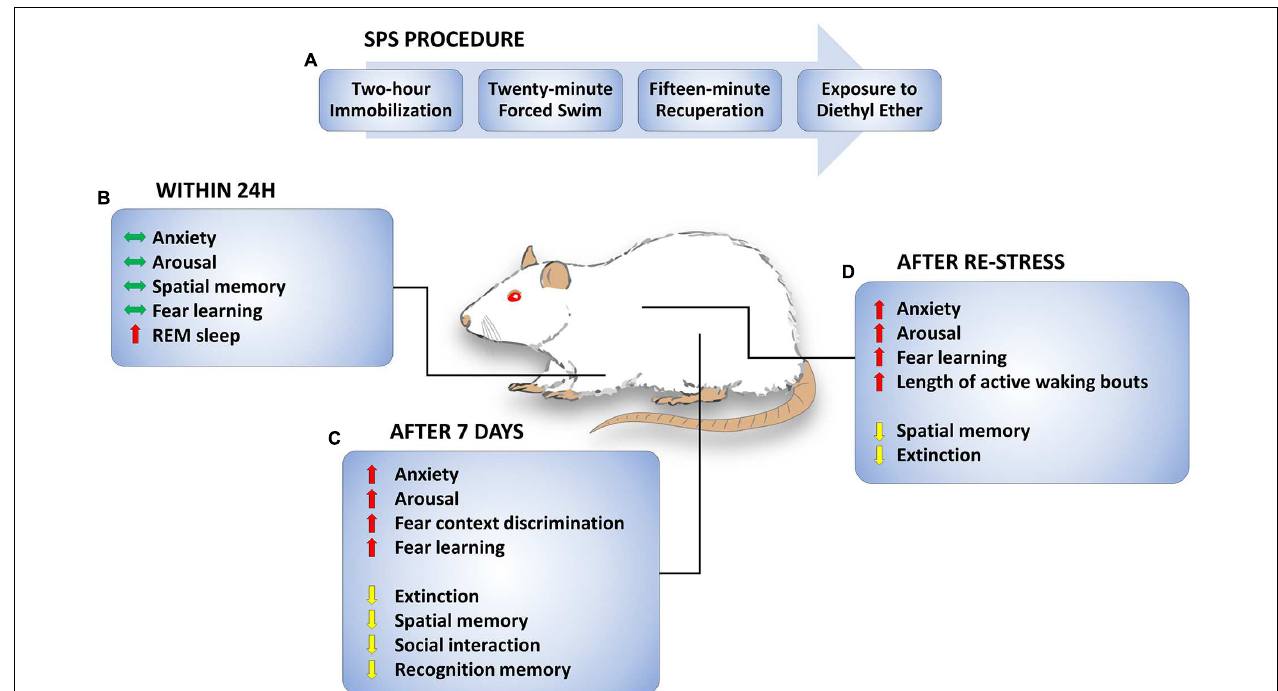
FIGURE 1 | Single prolonged stress (SPS) procedure and SPS-induced behavioral changes. (A) Timeline of SPS procedure. On a single day, rats are subjected to a 2-h immobilization followed immediately by a 20-min forced swim. Rats are given a brief period of recuperation and then subjected to diethyl ether until they are anesthetized and unresponsive. (B) Behavioral changes observed up to 1 day later. Anxiety, arousal, spatial memory, and fear learning are unchanged. Acute increase in REM sleep and transition to REM sleep is observed. (C) Behavioral changes 1 week later. Anxiety, arousal, fear context discrimination, and fear learning are increased. On the other hand, extinction, spatial memory, social interaction, and recognition memory are decreased a week after SPS. (D) Behavioral changes following re-stress. Enhanced anxiety, arousal, fear learning, and sleep disturbances remain observed following re-stress, while extinction and spatial memory are impaired. Green, red, and yellow arrows indicate no “changes observed”, “increase”, and “decrease”, respectively.